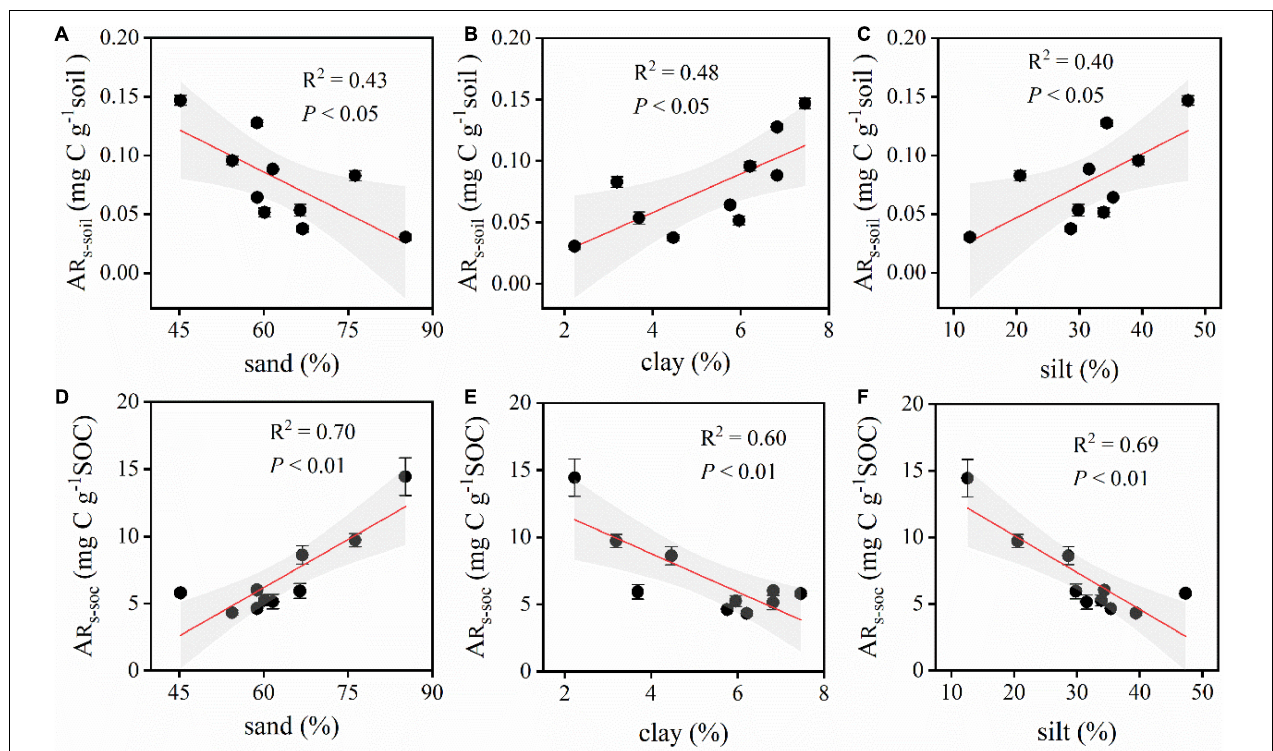
FIGURE 7 | Relationships between A Rs − soil , A Rs − SOC , and the different proportions of the soil components. A Rs − soil , accumulative emission of CO 2 relative to soil mass; A Rs − SOC , accumulative emission of CO 2 relative to SOC. (A) Relationships between A Rs − soil and sand. (B) Relationships between A Rs − soil and clay. (C) Relationships between A Rs − soil and silt. (D) Relationships between A Rs − SOC and sand. (E) Relationships between A Rs − SOC and clay. (F) Relationships between A Rs − SOC and silt. Shaded areas indicate the 95% confidence interval and vertical bars denote SE.